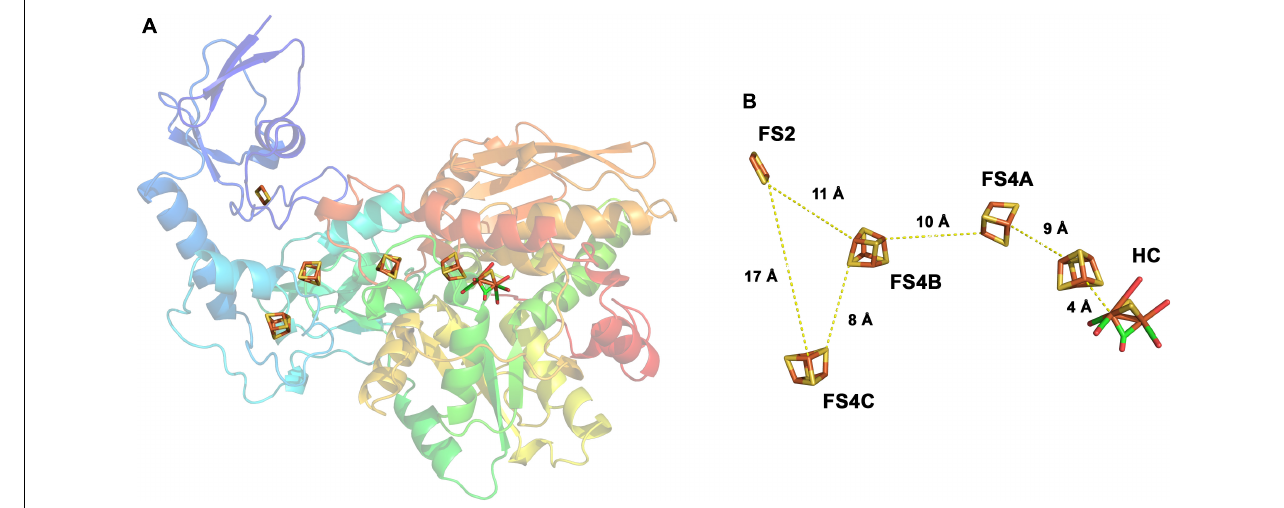
FIGURE 3 | Structure of the monomeric ferredoxin-dependent hydrogenase of C. pasteurianum . The 3D structure has been solved at 1.8 Å resolution (1FEH, RSCB PDB database). The monomeric enzyme contains the H-cluster typical for [FeFe] hydrogenases including the auxiliary [4Fe–4S] cluster. In addition, one